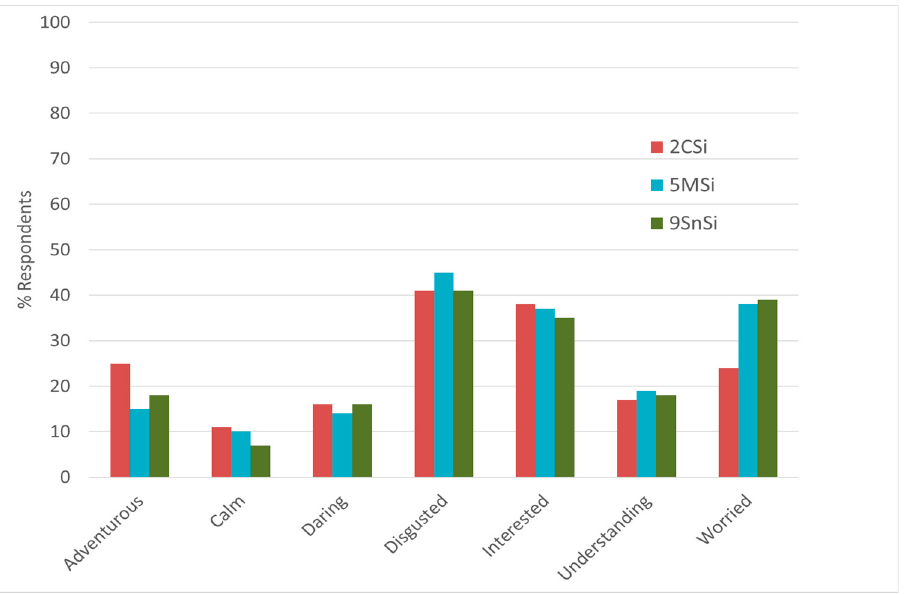
Figure 8. Estimated percentage of respondents considering the emotions for which either the Sustainability Information or the Product Category had a significant effect, and the treatments for which both the Sustainability Information and Insects Presence Information were given. Significance testing was not done across the treatments because the main focus of the study was to study the effects of the experimental design factors. Treatment abbreviations can be found in Table